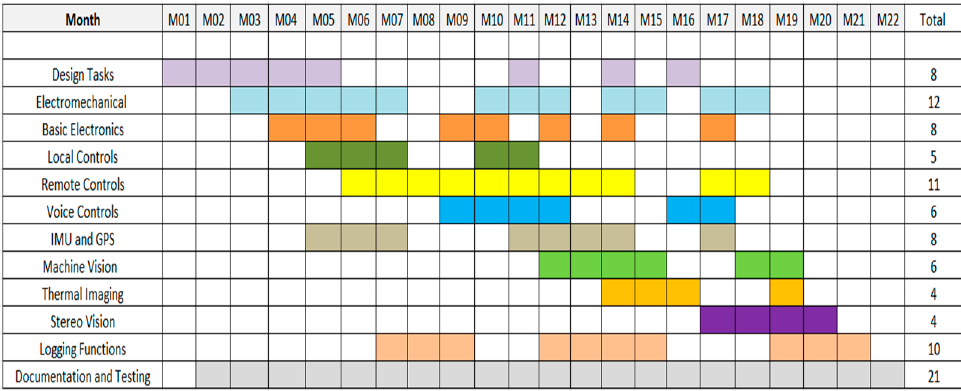
Figure 14. The time span of the most characteristic activities for the robotic projects’ completion.